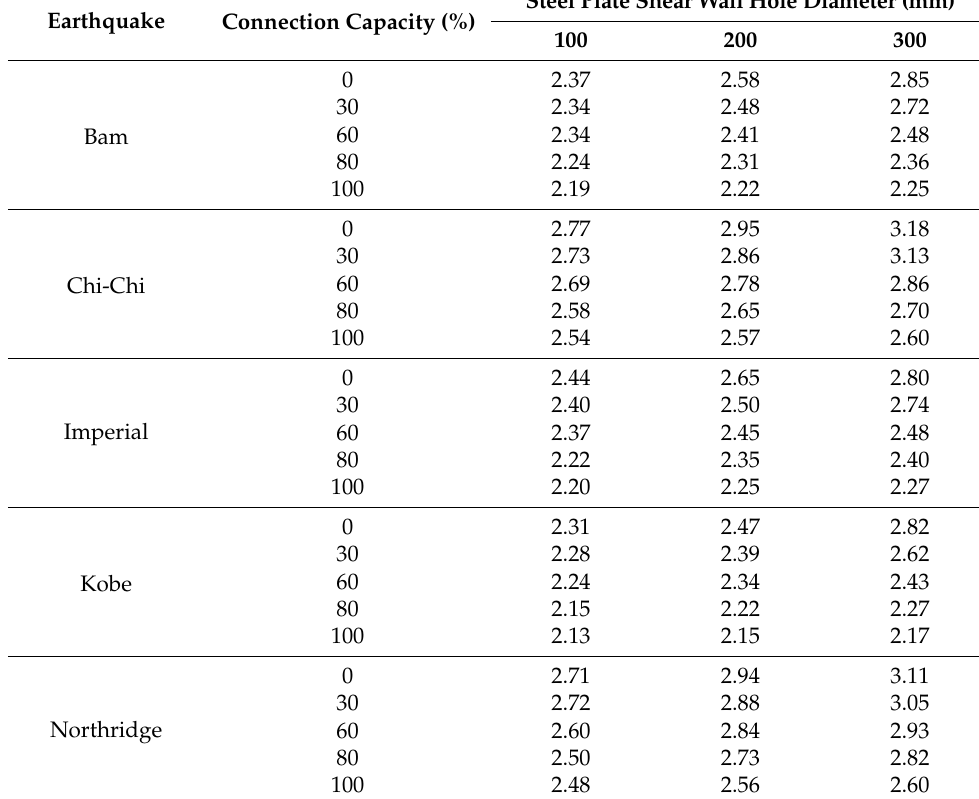
Figure 21. Maximum story drifts of 15-story frame subjected to 5 earthquake records. Table 7. Maximum story drift of 5-story frames.